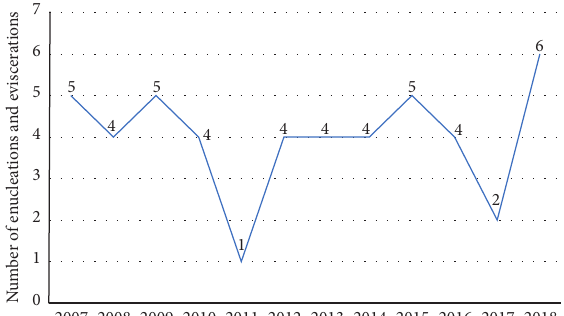
Figure 2: Annual number of enucleations and eviscerations due to microbial keratitis between 2007 and 2018 at the Department of Ophthalmology of Semmelweis University (Budapest,